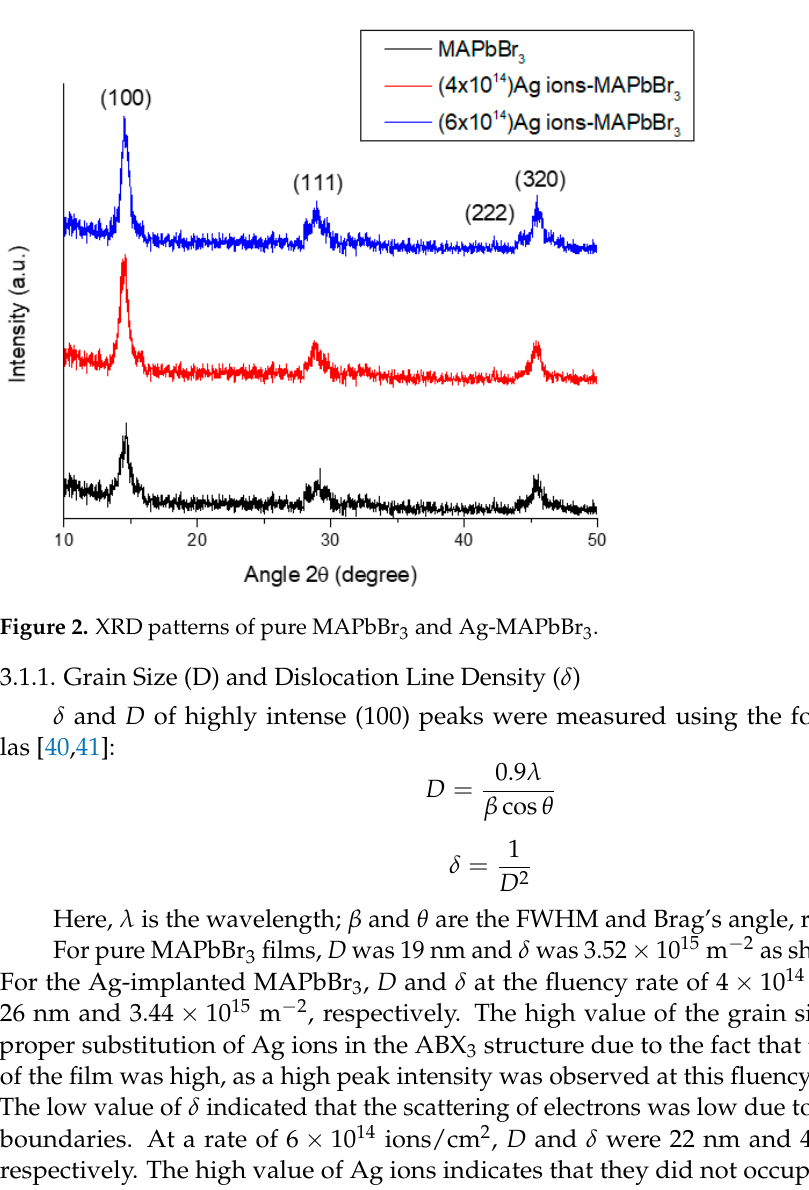
Figure 3. For the Ag-implanted MAPbBr 3 , D and ions/c m 2 were 26 nm and , respectively. The high value of the grain size